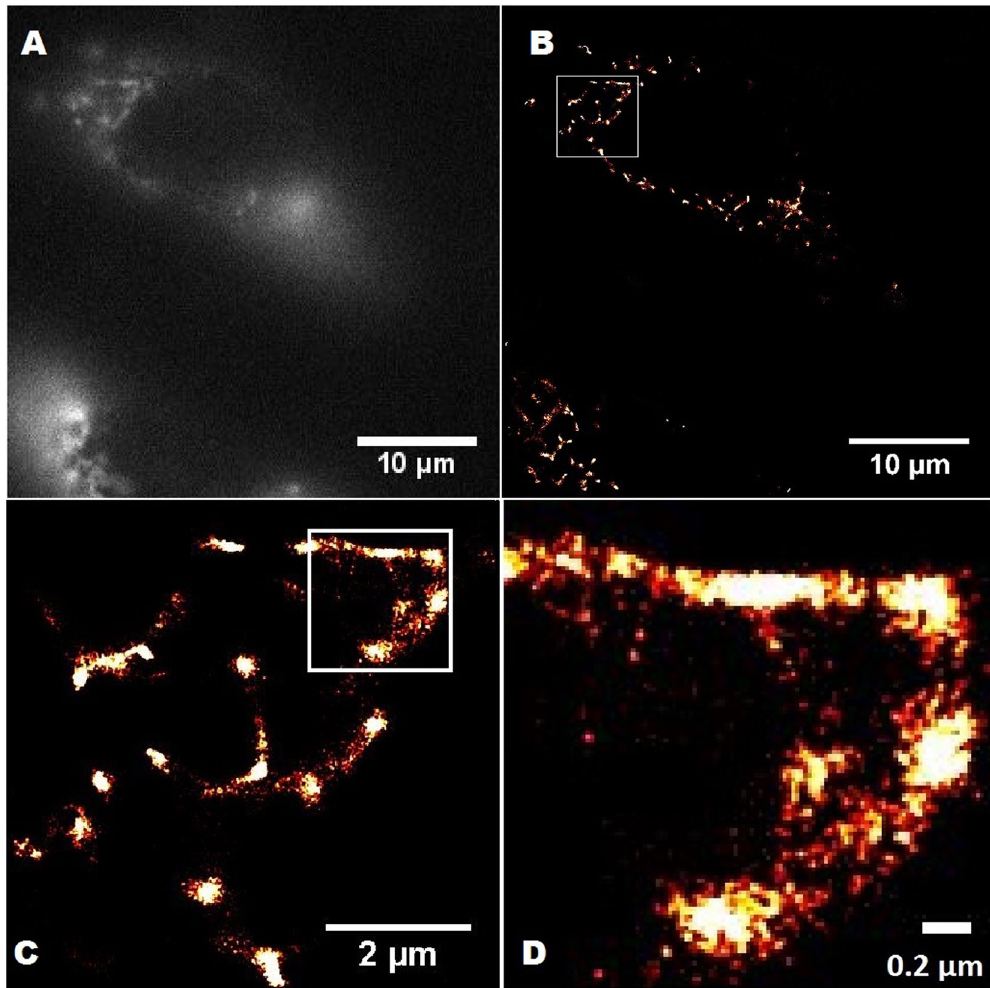
Figure 10. Near-TIRF widefield image ( A ) and PALM different scales images ( B – D ) with region of interest of Hep2 cells transfected with pVimentin-SAASoti/V127T vector. Images were captured using a TIRF 100x objective, using a CCD camera with 160 nm effective pixel size. Exposure time per frame was 30 ms. In near- TIRF mode (with slight sample penetration) a 561 nm laser was used for excitation, with a 580 nm emission bandpass filter in the detection pathway. A 405 nm laser was used for photoconversion from green to red. One measurement cycle involved photoconversion with a 405 nm laser for 1 frame and then excitation with a 561 nm laser for 3 frames (1 – registration of the signal at 561 nm, 2,3 – bleaching of the signal at 561 nm). The whole measurement comprised of 500 cycles. Every second frame of the cycle was used for analysis. Images were analyzed using the ThunderSTORM plugin of